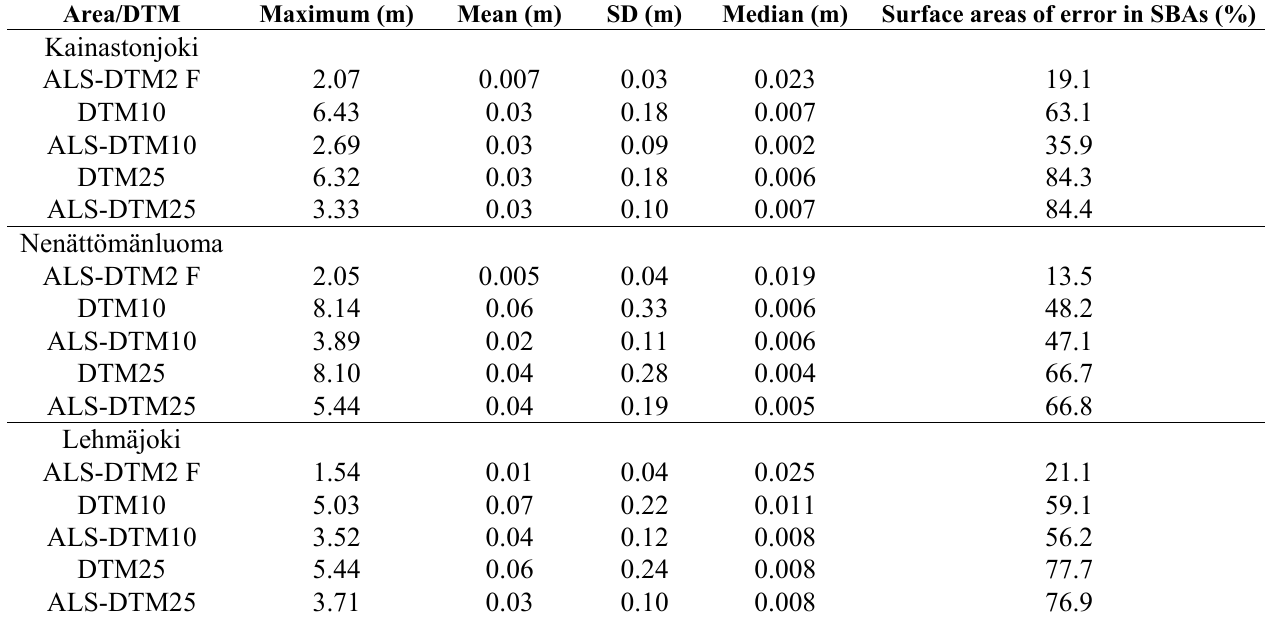
Table 9. Depth error in relation to ALS-DTM2.